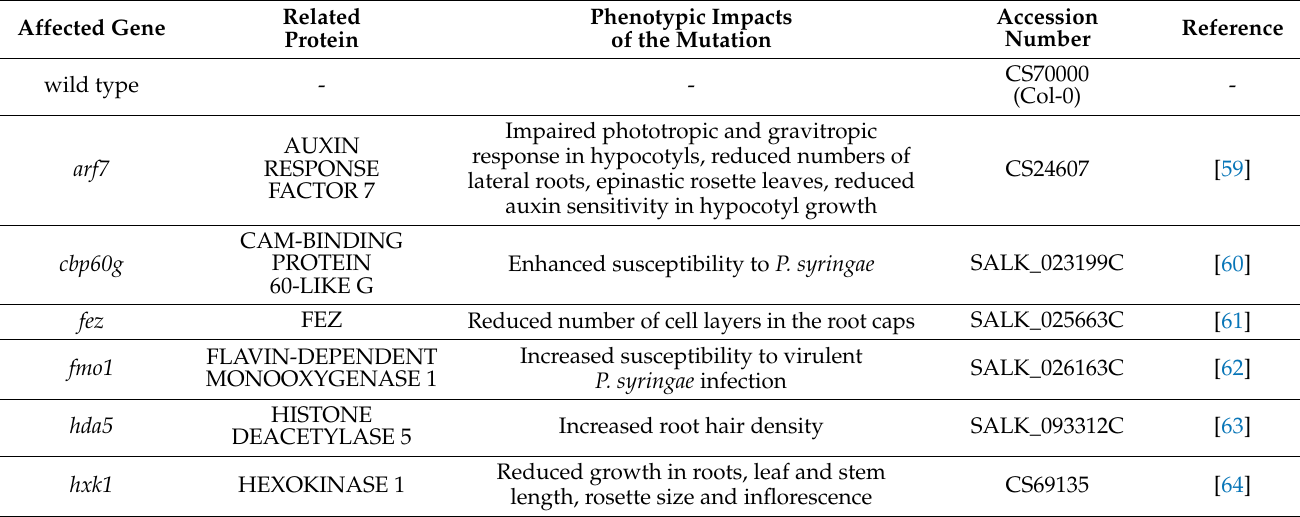
Table 1. Genotypes of A. thaliana used in this study. All mutant strains derive from Col-0. Ad- ditional characteristics are available on The Arabidopsis Information Resource website (https: //www.arabidopsis.org/, accessed on 13 March 2018). Phenotypic Impacts of the